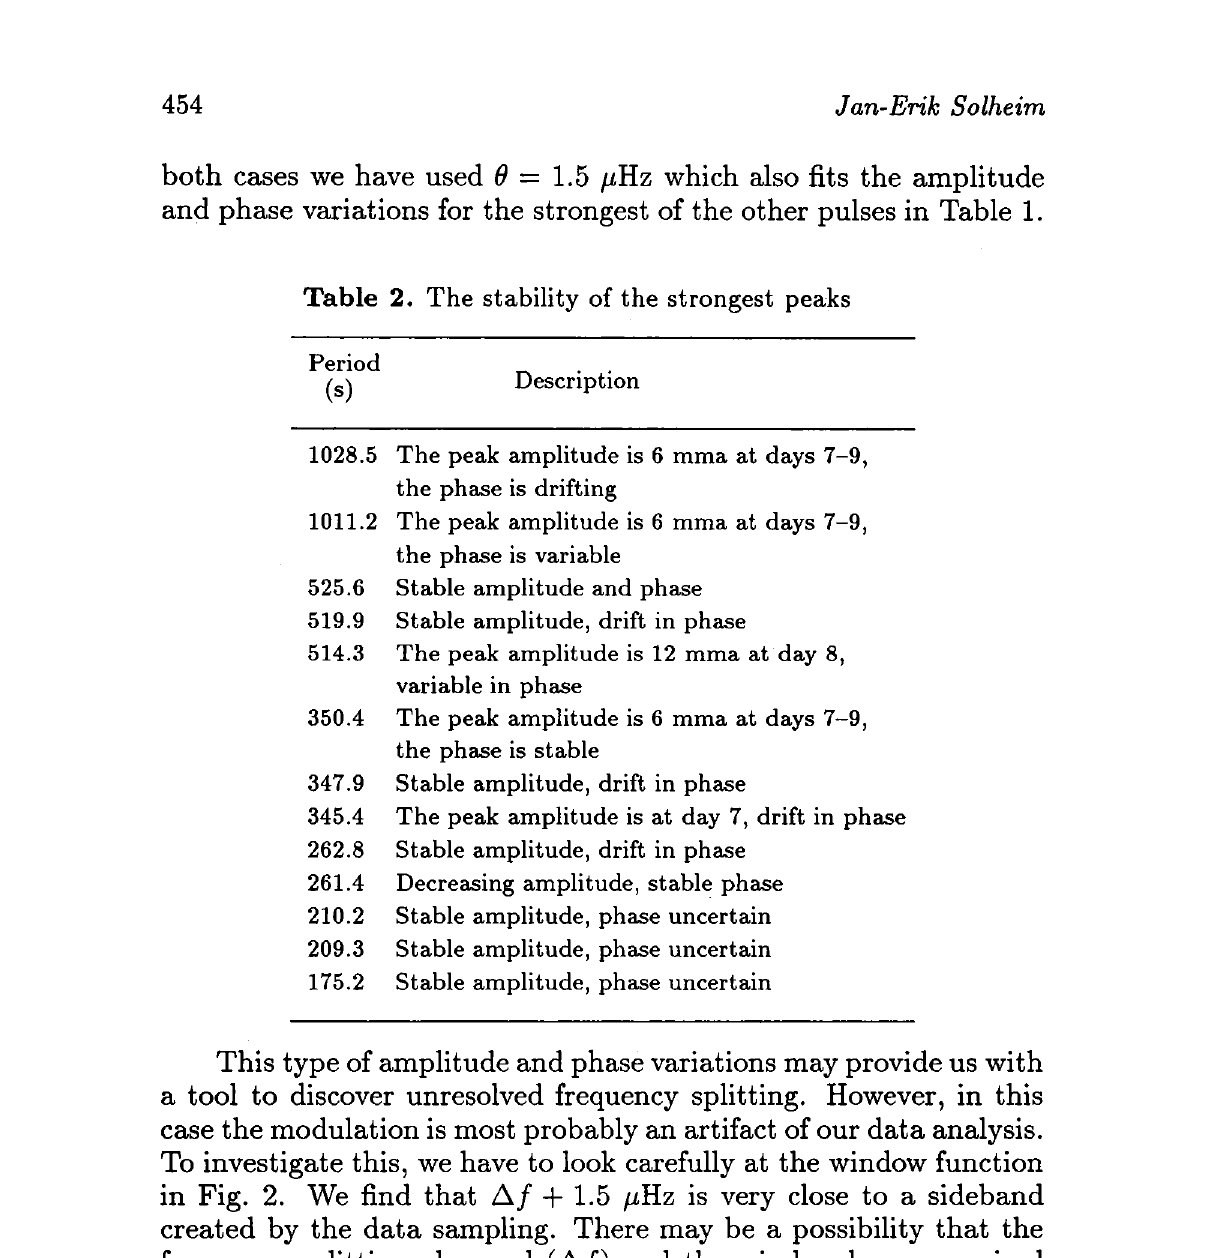
Table 2. The stability of the strongest